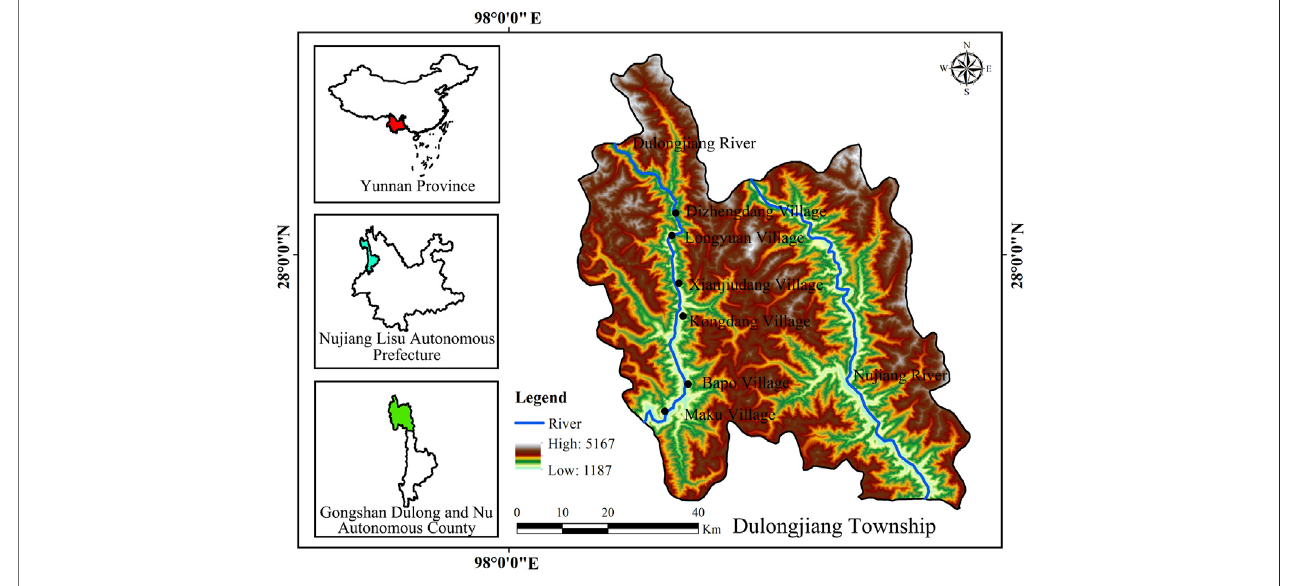
FIGURE 1 | Study area.